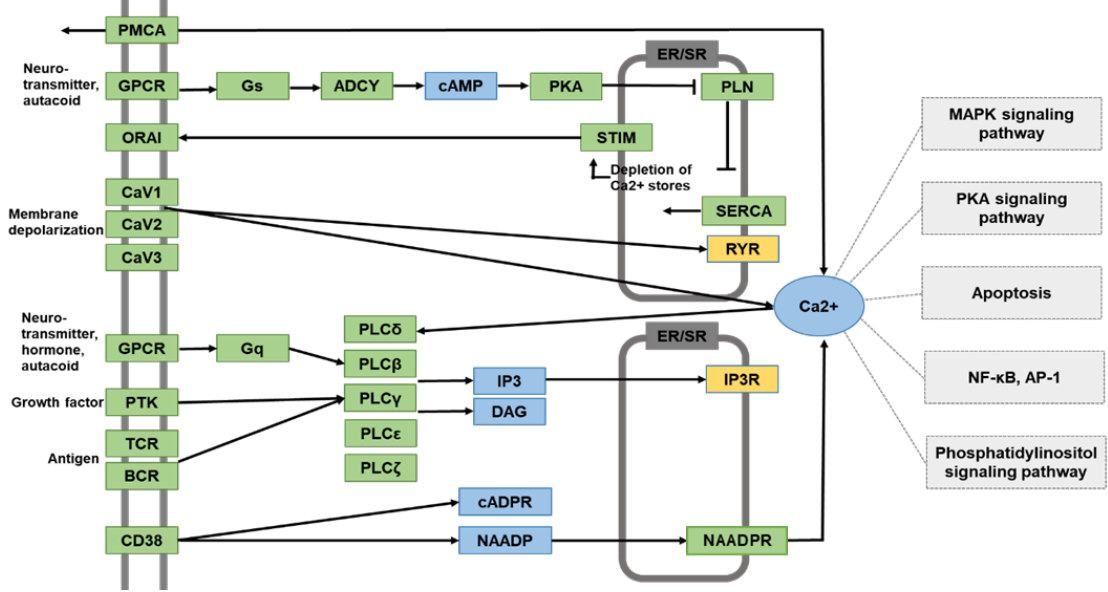
Figure 2. A schematic of the Ca 2+ signaling network derived from Kyoto Encyclopedia of Genes and Genomes (KEGG). The filtered DEGs identified by the RNA-Seq analysis are colored in yellow boxes (ryanodine receptor (RYR), inositol triphosphate receptor (IP3R)). The molecular pathways associated with Ca 2+ signaling are colored in light grey boxes (mitogen-activated protein kinase (MAPK), protein kinase A (PKA), Apoptosis, nuclear factor kappa-light-chain-enhancer of activated B cells (NF- κ B), activator protein-1 (AP-1), phosphatidylinositol signaling pathways). The molecules in blue are second messengers in signaling transduction pathways.